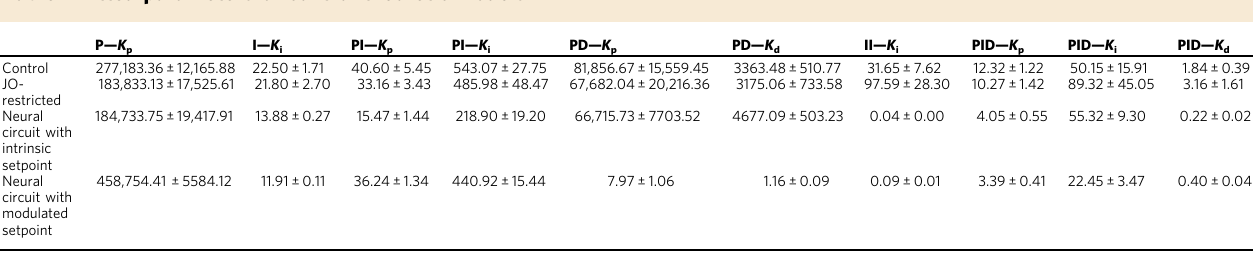
Mean fi tted parameter values for each of the control theoretic models along with the standard error of the mean